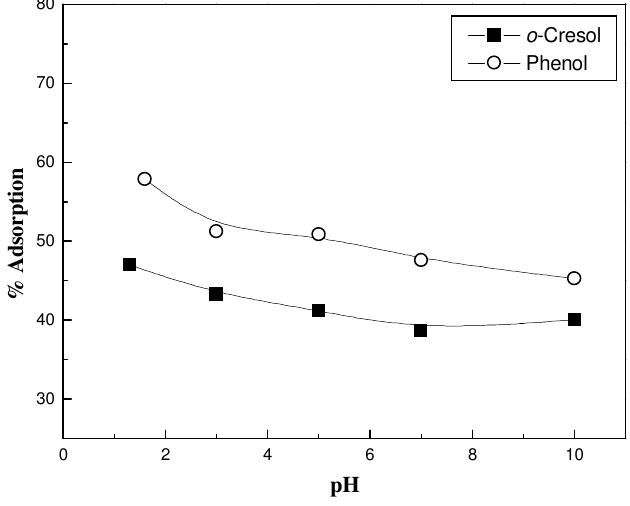
Figure 2. Effect of pH on the adsorption of phenols on CC